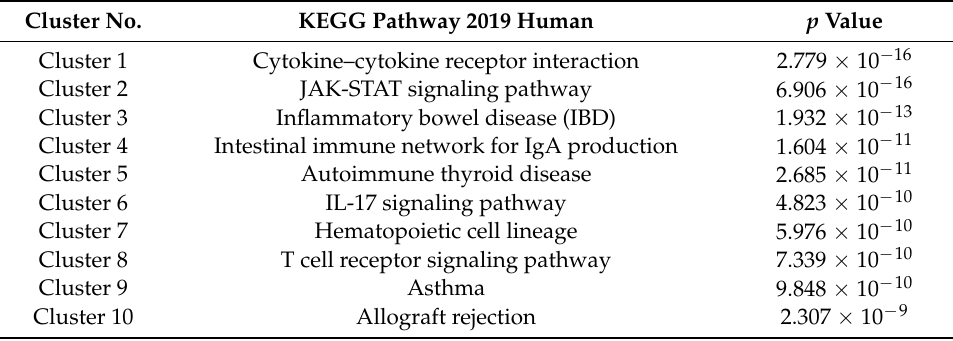
Figure 2. Pathway analysis performed on the “Enrichr” platform. The enriched pathway terms are displayed in a bar graph ( A ). The length of the bar and the brightness of its color represent the significance of the specific pathway. Clustergram of pathways of MEO ( B ). Those clusters are ranked by p value. The colors of the boxes represent each cluster. Table 2. Cluster of the enriched pathway of MEO.